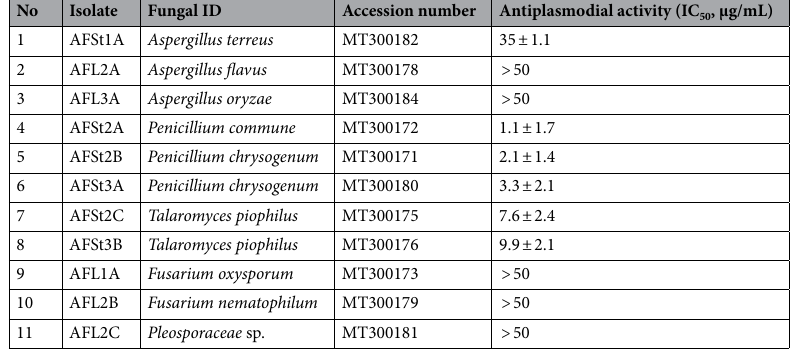
Table 1. A. annua -derived fungal endophytes and their GenBank accession numbers, and the in vitro anti- plasmodial activity of their corresponding extracts.